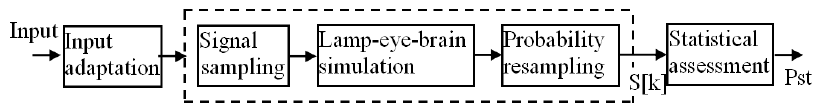
Figure 2. Basic principle of probability